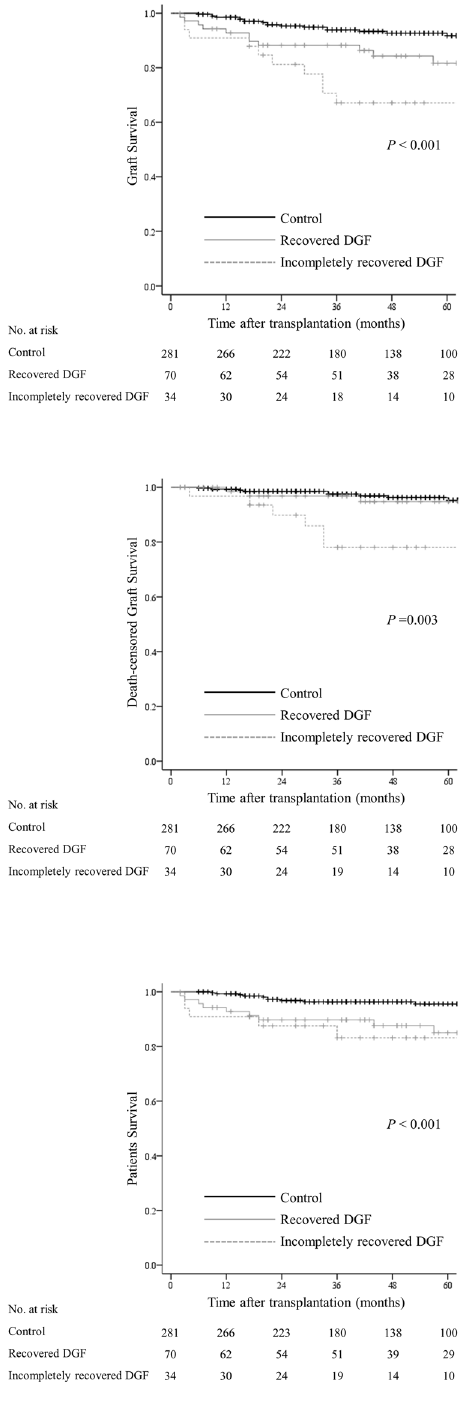
Figure 2. Graft and patient survival according to delayed graft function status. ( a ) Graft survival. ( b ) Death- censored graft survival. ( c ) Patient